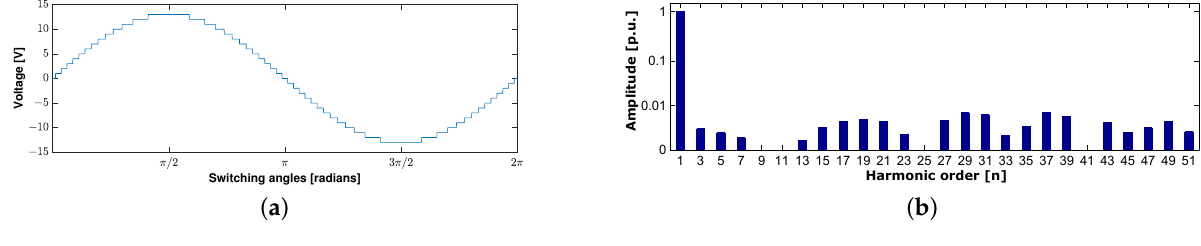
Figure 5. Simulation for 27-level multilevel converter with nearest level control: ( a ) output voltage, ( b ) voltage harmonic